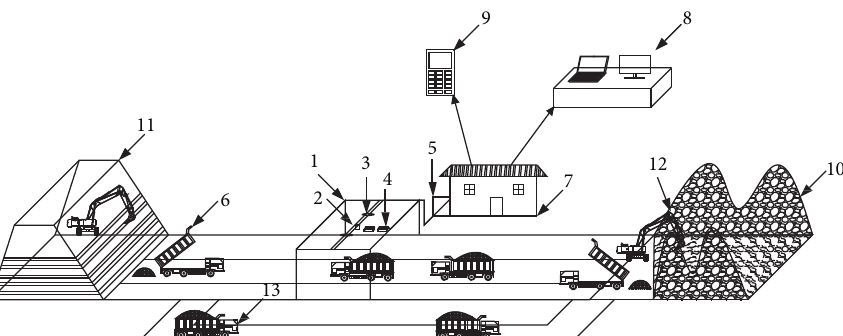
Figure 1: Illustration of an on-site gradation detecting system for earth and stone materials. Note .1: test station; 2: industrial camera; 3: LED lamp; 4: sprinkler; 5: water supply system; 6: vehicle transporting qualified aggregate; 7: field data processing and storage terminal; 8: remote terminal and storage system; 9: mobile terminal; 10: stock ground for earth and stone materials; 11: construction site; 12: excavator for loading and remixing; 13: unqualified material.